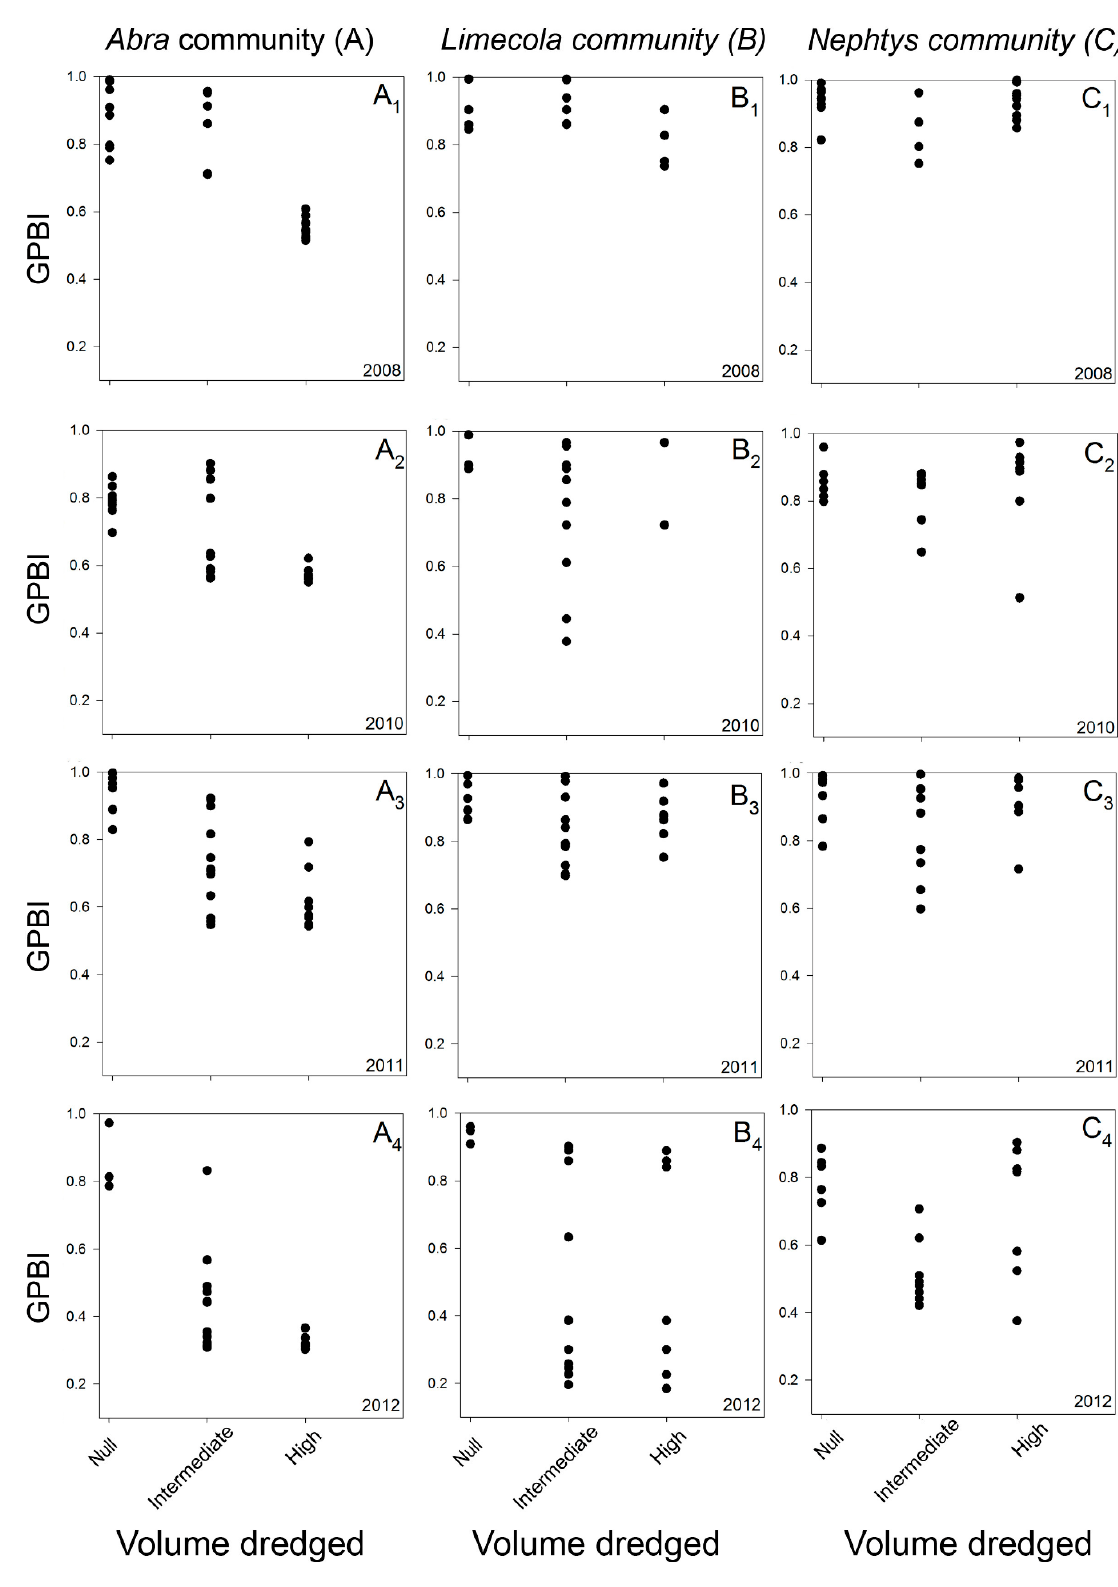
Figure 3. Case Study 2—dredge disposal (Belgium, North Sea). Relationship between the volumes dredged as intermediate and high versus GPBI for the Abra alba community in 2008 ( A1 ), 2010 ( A2 ), 2011 ( A3 ), and 2012 ( A4 ); the Limecola balthica community in 2008 ( B1 ), 2010 ( B2 ), 2011 ( B3 ), and 2012 ( B4 ); and the Nephtys cirrosa community in 2008 ( C1 ), 2010 ( C2 ), 2011 ( C3 ), and 2012 ( C4